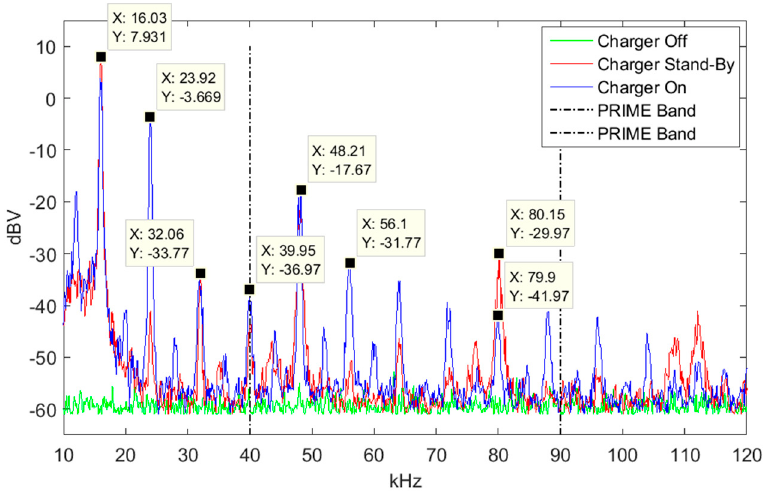
Figure 17. Spectrum recorded at the battery charger SM with the rest of surrounding devices connected.